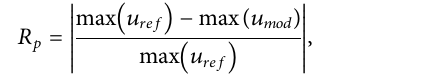
Frontiers in Earth Science |